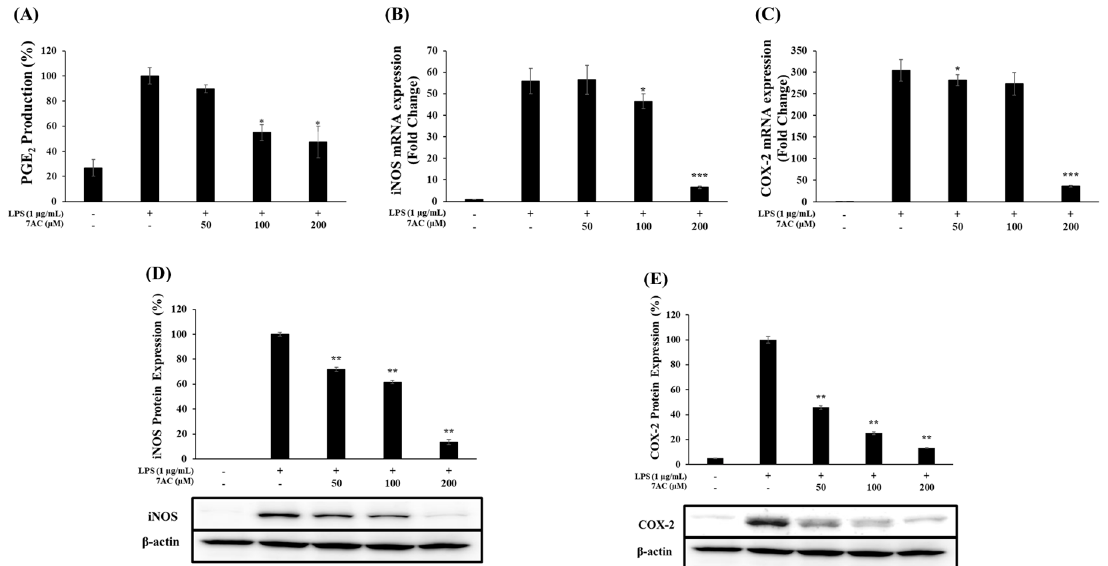
Figure 4. Effects of 7AC on PGE 2 production and the protein and mRNA levels of iNOS and COX-2 in LPS-stimulated RAW 264.7 cells. ( A ) Production of PGE 2 was assayed in the culture medium of cells stimulated with LPS (1 μ g/mL) for 24 h in the presence of 7AC (50, 100 and 200 μ M) by ELISA; ( B , C ) mRNA and ( D , E ) protein levels of iNOS and COX-2 were determined by qRT-PCR and western blot, respectively. The data represent the mean ± SD of triplicate experiments. * p < 0.05, ** p < 0.01, *** p < 0.001 versus LPS alone.